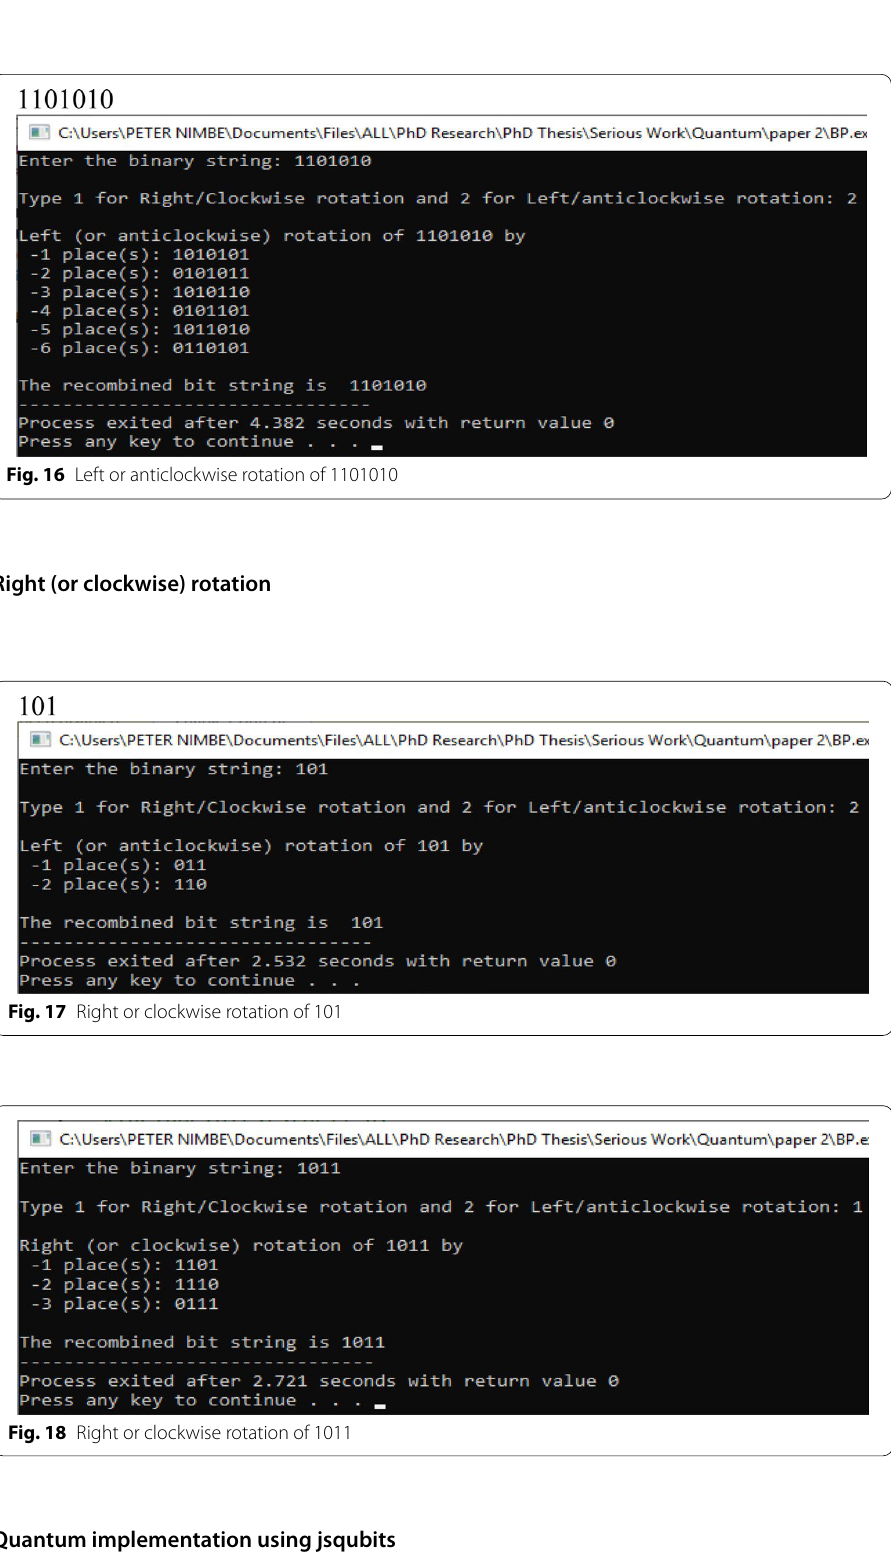
Quantum implementation using jsqubits